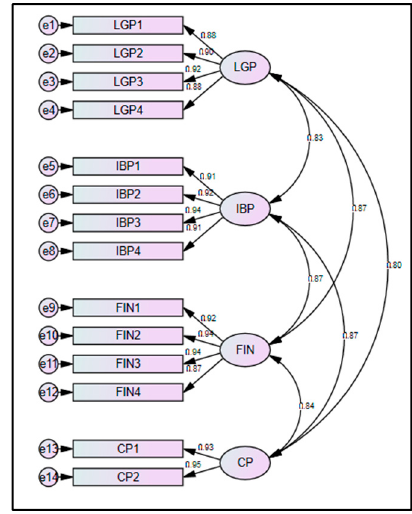
Figure 1. Confirmatory factor analysis (CFA).